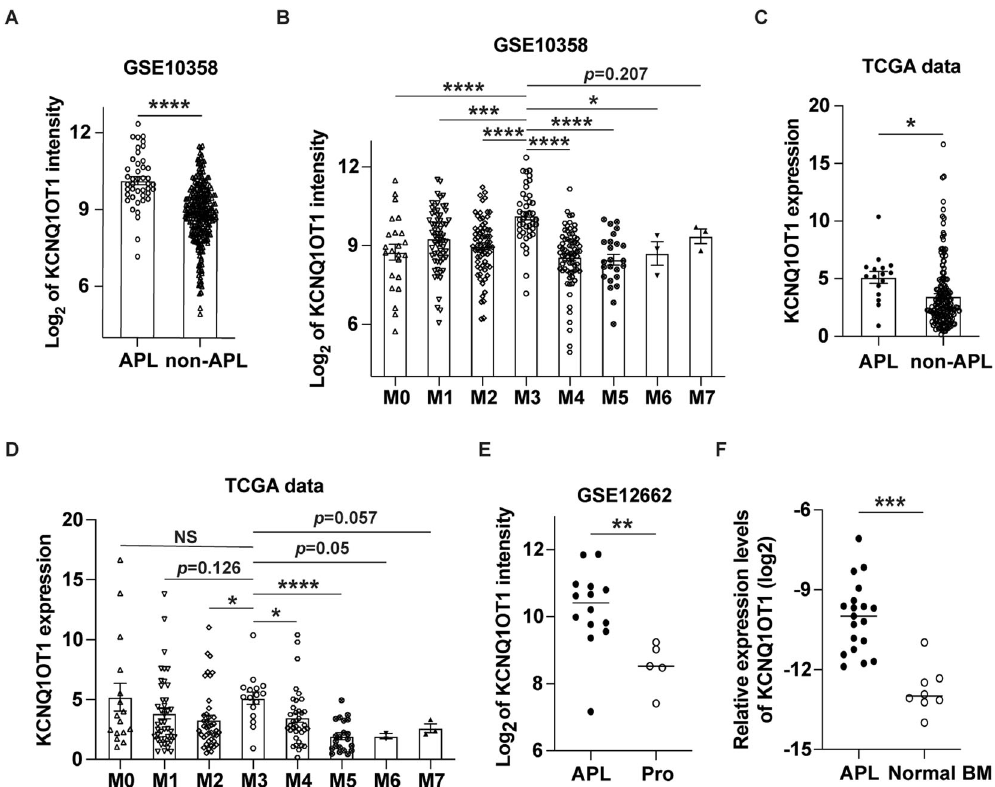
Fig. 1 KCNQ1OT1 is highly expressed in APL. A – D The expression of KCNQ1OT1 in different FAB subtypes from two AML patient cohorts (GSE10358 and TCGA). E The expression of KCNQ1OT1 in APL and normal promyelocytes (Pro) was retrieved from GEO (GSE12662).